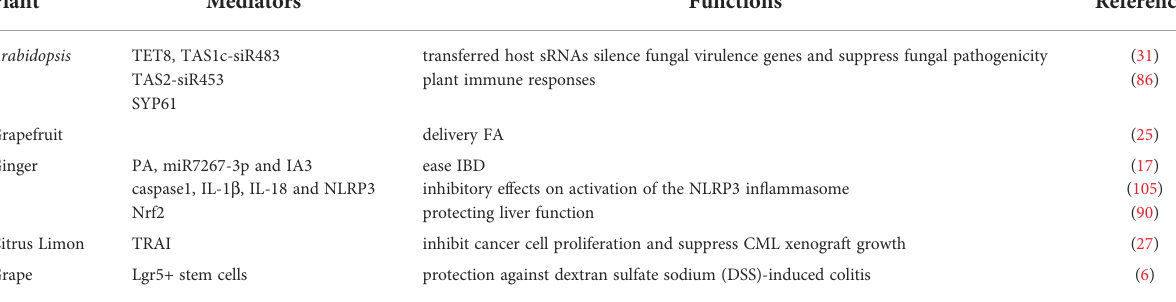
TABLE 3 Overview of the biological functions of EVs from a variety of plant sources.